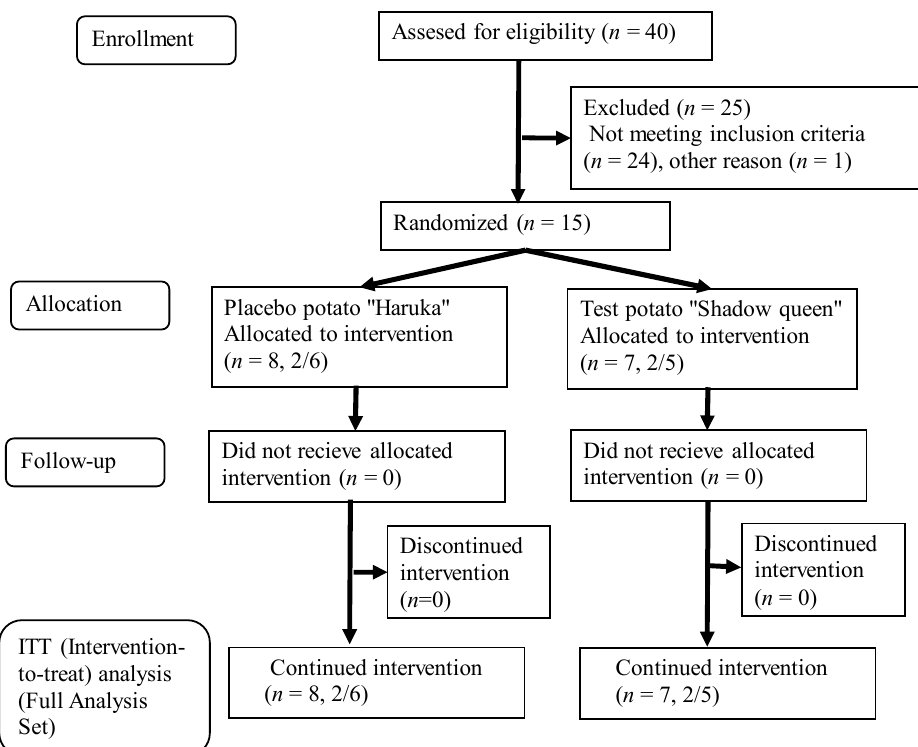
Figure 2. Study flowchart ( n = total participants, male/female). Table 2. Baseline characteristics of subjects in the test (“Shadow Queen”) and placebo (“Haruka”) groups. Baseline Characteristics